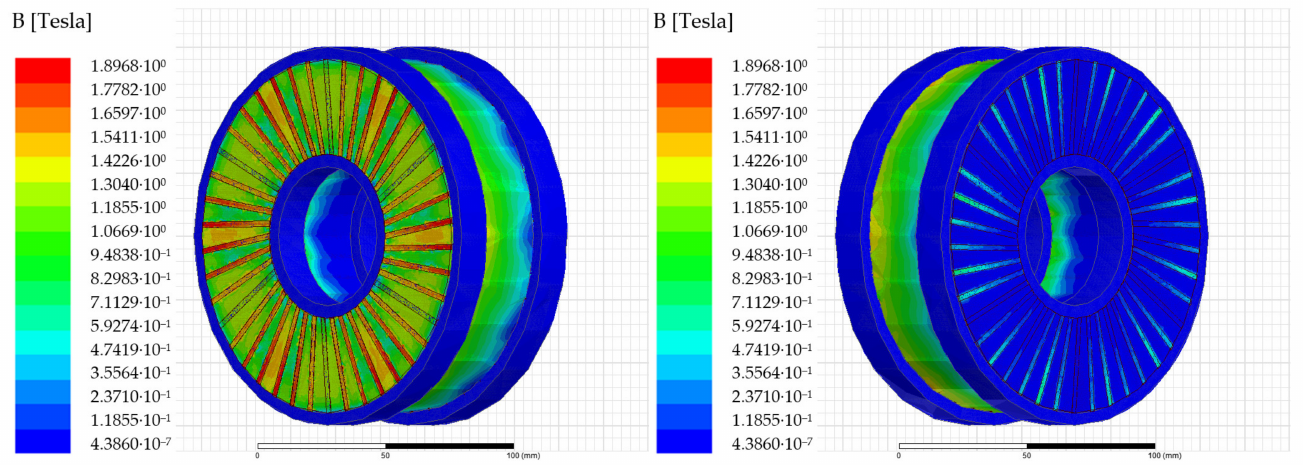
Figure 11. A nominal current flowing through the bars of the left side of the inner rotor (air gap δ 1 ) ( left ); zero current flowing through the bars of the right side of the inner rotor (air gap δ 2 ) ( right